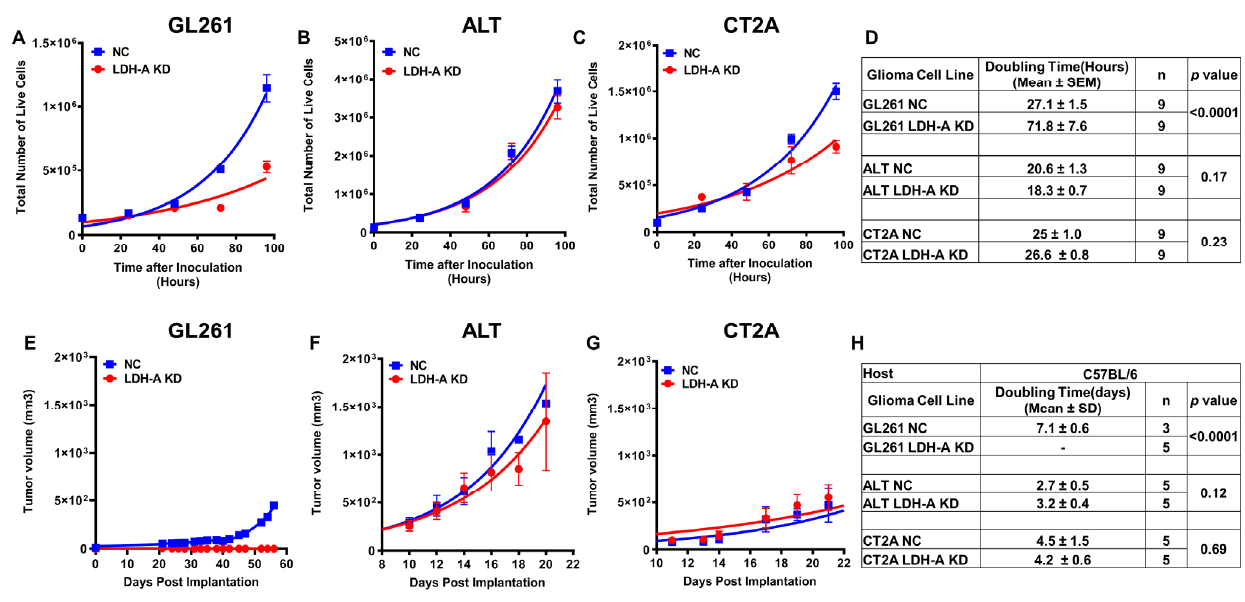
Figure 4. The effect of LDH-A knock-down on cells in vitro and s.c. tumor growth, in vivo in immune-competent mice . Growth profiles and doubling times of GL261, ALTS1C1 and CT2A cells in vitro (Panels A – D ) (mean ± SEM) and tumors in C57BL/6 mice (Panels E – H ) with and without LDH-A shRNA knock-down (mean, ± SD). Note that the doubling times for GL261 NC tumors (Panel E) were estimated after the initial delay in tumor growth (0~40